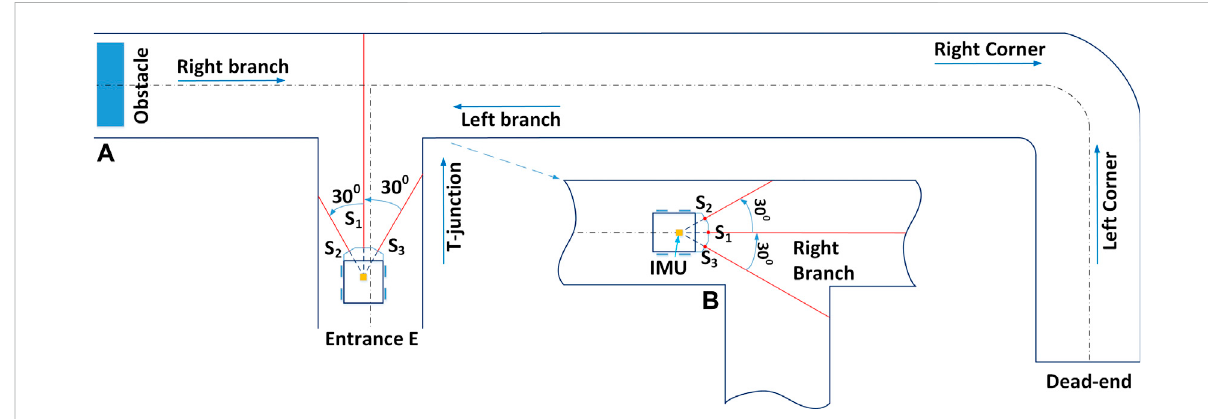
FIGURE 2 Diagrams of Joey robot operating inside a schematic of our experimental pipe network. Panel (A) depicts the Joey robot at starting point (Entrance E) of a typical imitation in laboratory setting of a real sewer pipe network at the Integrated Civil and Infrastructure Research Centre, University of Shef fi eld (ICAIR). The imitated pipe network includes features of the real network such as T-junction, corners, branches, dead-end and obstacle. Panel (B) illustrates the robot coming from the left side of the network in Panel (A) . Panel (B) also illustrates the left/right ranging direction which form angles of 30 ° with robot front-back